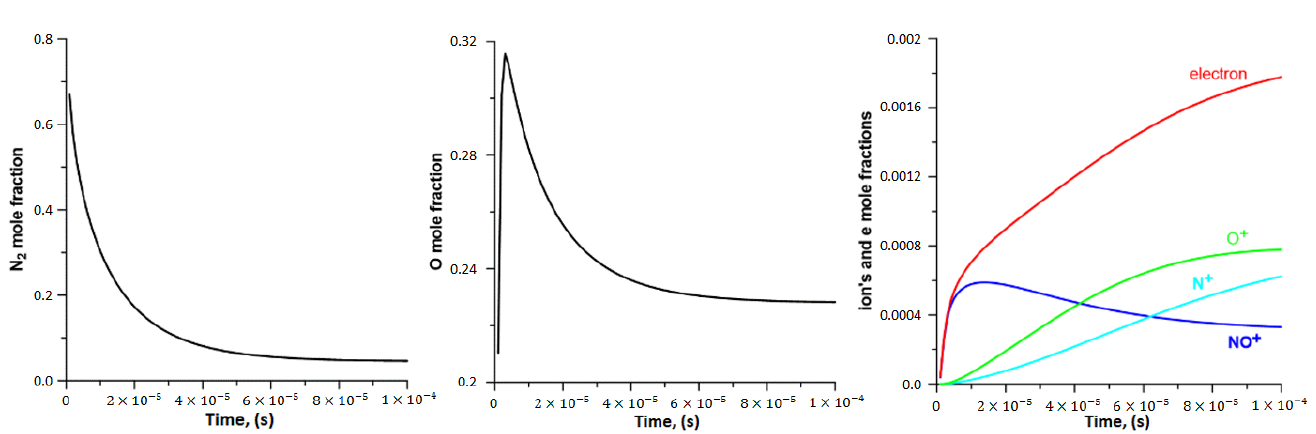
Figure A1. Time dependencies of N 2 , O and charged particle mole fractions in the 0D simulation using Plasmaero.